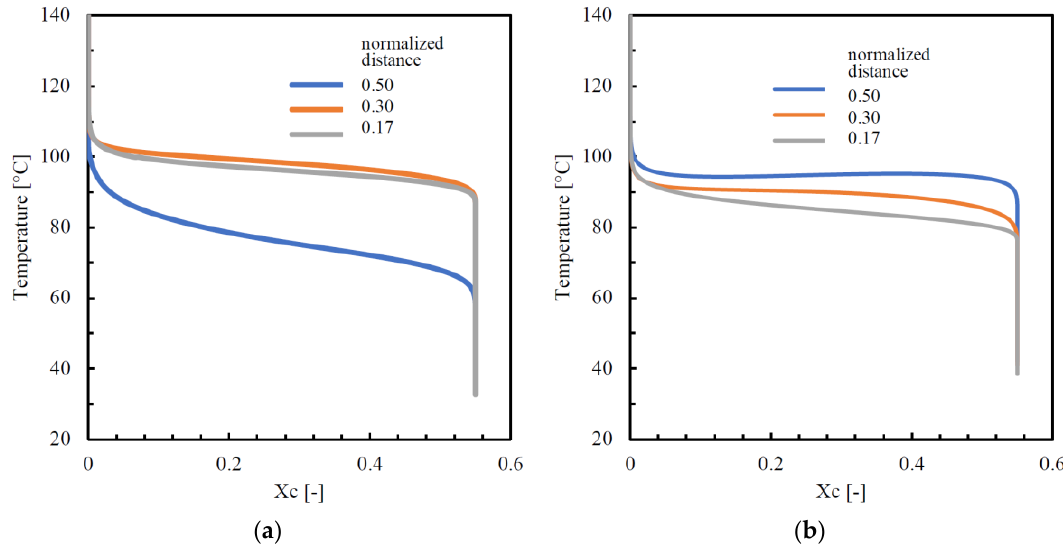
Figure 13. The temperature during the crystallization for the samples passive ( a ) and B ( b